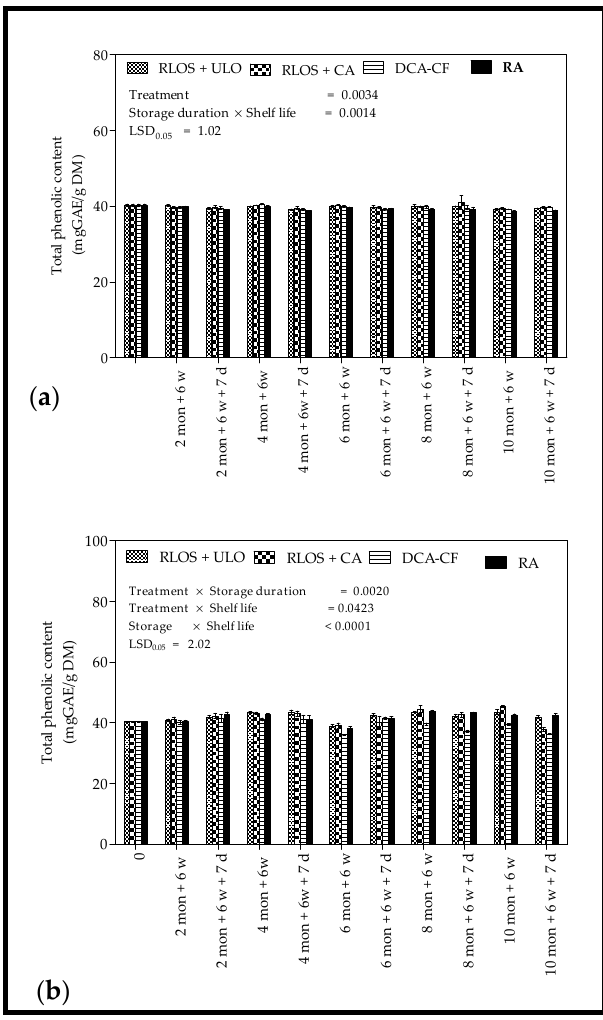
Figure 8. Total phenolic content (mgGAE/g DM) of ‘Granny Smith’ apples harvested in the 2015 ( a ) and 2016 ( b ) seasons at commercial maturity and stored for up to 10 months at 0 °C in various storage conditions, evaluated every two months followed by a 6 week simulated shipment and handling period, and at 7 days on the shelf (20 °C and 65% RH). Vertical bars represent the standard error (SE) of mean values of 3 replicates (1 replicate = 10 fruit). LSD 0.05 represents least significant difference ( p < 0.05). For storage duration, mon— months; w—weeks; and d—days. RLOS—repeated low oxygen stress; ULO—ultra-low oxygen; CA—controlled atmosphere; DCA-CF—dynamic controlled atmosphere-chlorophyll fluorescence; RA—regular